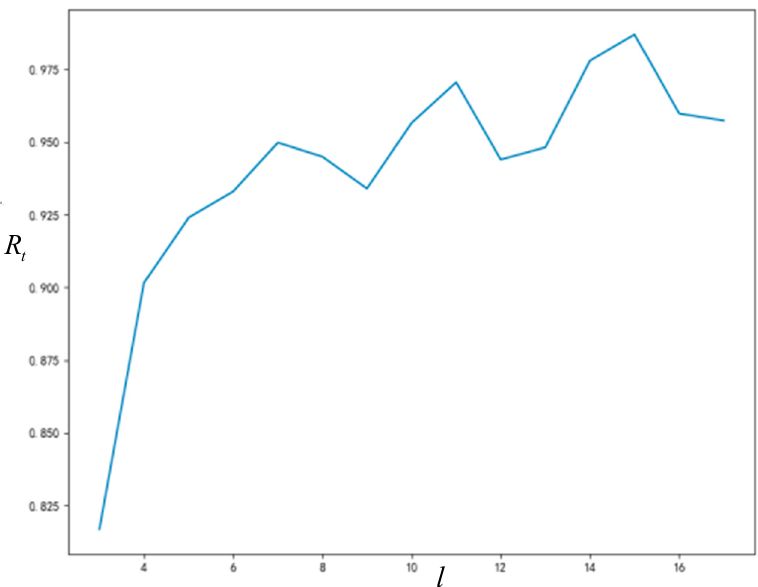
Figure 7. The relationship diagram among σ , µ 0 and T .